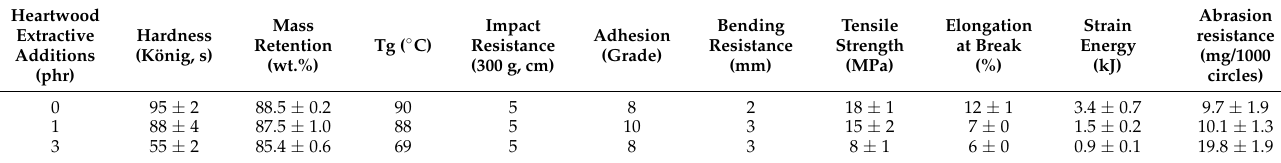
Table 4. Film properties of ROL with various A. confusa heartwood extractive